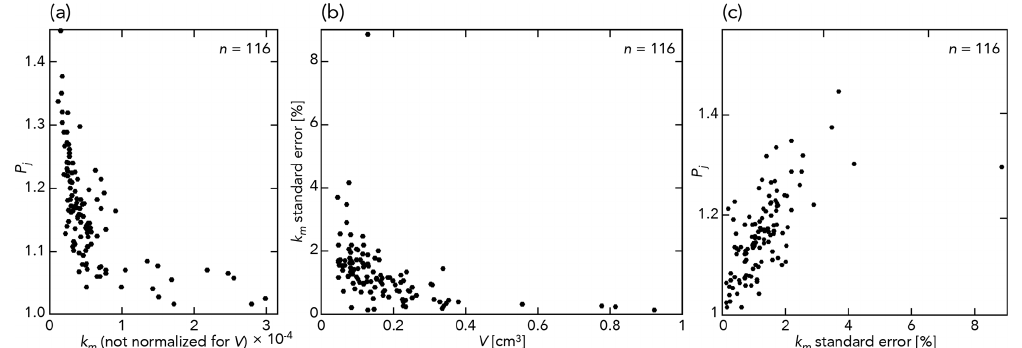
Figure 13. Influence of specimen size on the degree of magnetic anisotropy. (a) Without normalization for specimen volume, anisotropy degree ( P j ) decreases with increasing mean susceptibility ( k m ). (b) Cube volume plotted against the standard error of the mean susceptibility. (c) Degree of anisotropy ( P j ) as a function of standard error (see Sect. 3.2 for the calculation of the standard error).